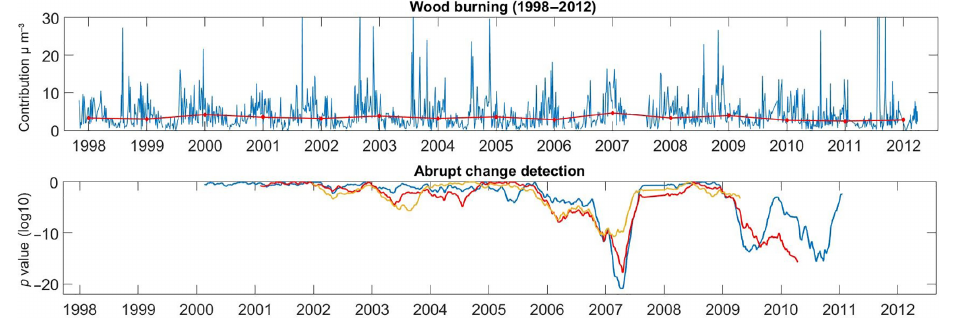
Figure 7. Top panel: time series of wood-burning contribution to PM 2 . 5 and the annual median in red. Bottom panel: p value from a Mann– Whitney hypothesis test comparing the median of both halves of a sliding window, repeated for three different window lengths (320, 480 and 640 days for blue, red and yellow, respectively).